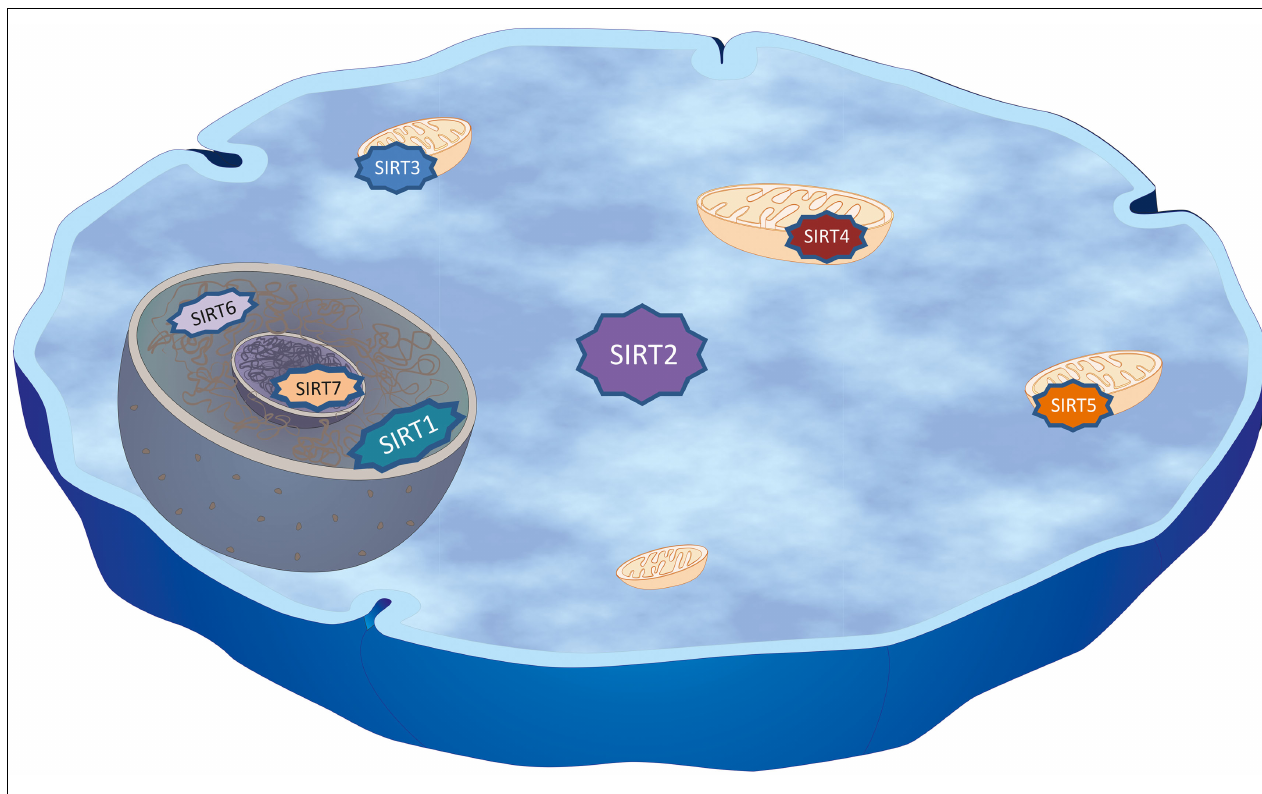
SIRT1, is primarily a cytoplasmic protein, but can transiently shuttle into the nucleus during mitosis, where it deacetylates Lys-56 of histone H3 and Lys-16 of histone H4. In the cytoplasm, SIRT2 deacetylates microtubules, in particular α -tubulin at Lys-40 and a variety of other substrates ( Table 1 ). SIRT3, SIRT4, and SIRT5 were found to co-localize with mitochondria indicating key regulative roles in metabolism and energy usage of the cell. SIRT6 is a nuclear protein found to regulate DNA repair, while SIRT7 co-localizes with the nucleolus and was shown to be involved in rRNA